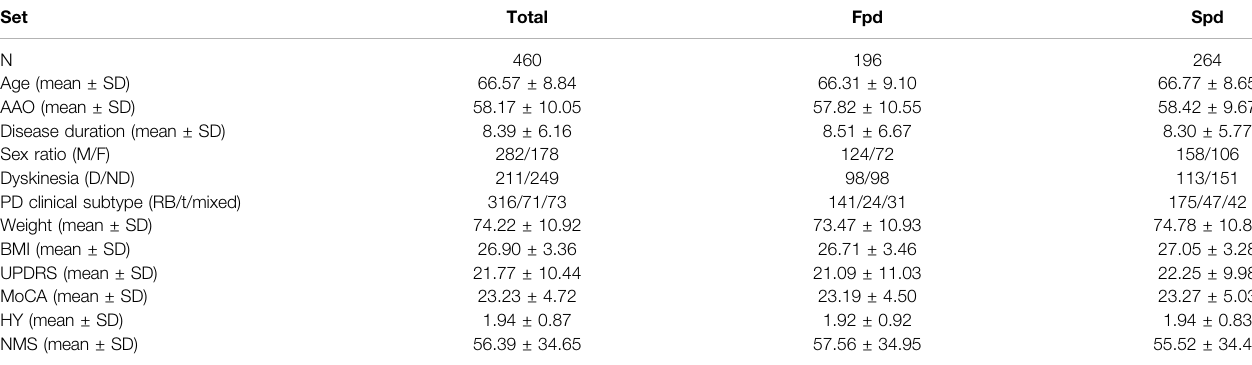
TABLE 1 | Description of the neuromed PD cohort used for analysis.